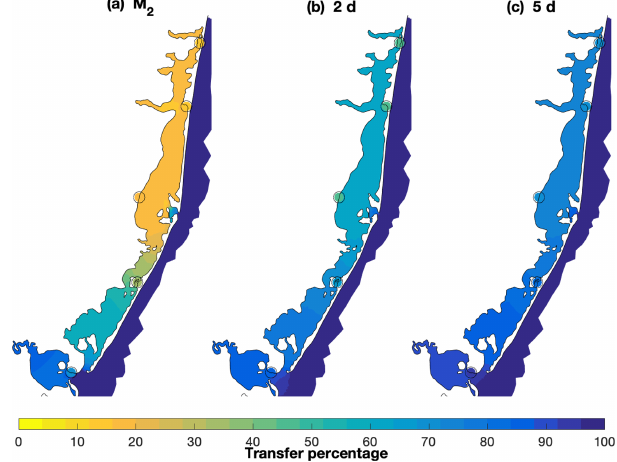
Figure 9. Spatially variable transfer function (percentage) of off- shore fluctuations transferred into the bays using Atlantic City as an offshore proxy for three frequencies: (a) M 2 semidiurnal tide, (b) 2d fluctuation in the storm band, and (c) 5d fluctuation in the storm band. The filled circles represent the transfer estimate at each of the observed locations. Spatial pattern computed using the COAWST numerical solution.